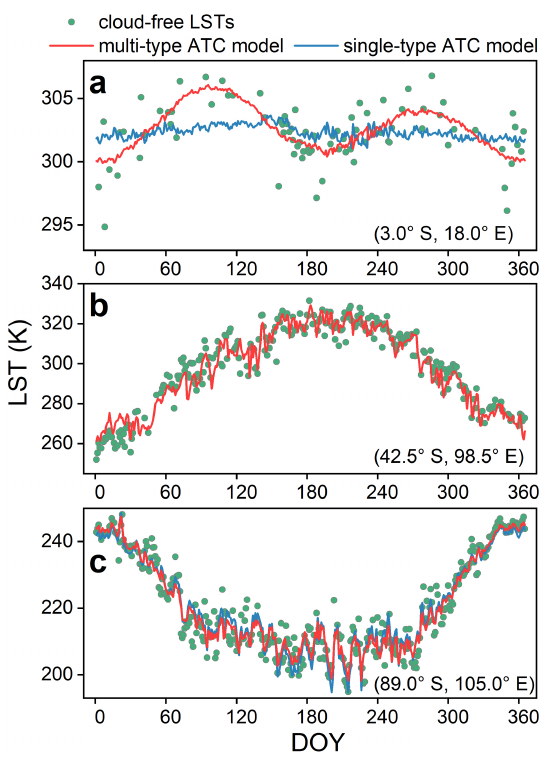
Figure 3. Comparison of reconstructing under-cloud LSTs with multi-type and single-type ATC models at different latitudes. Pan- els (a, b, c) show three examples of ATC modeling at low-latitudes, midlatitudes, and high-latitudes for cloud-free Terra-day LST in 2019. The green circles, blue lines, and red lines denote the cloud- free observations and LSTs simulated by the single- and multi-type ATC models, respectively. Note that for (b) , the results of the single- and multi-type ATC models are identical since they both use the ATC model with a single sinusoidal